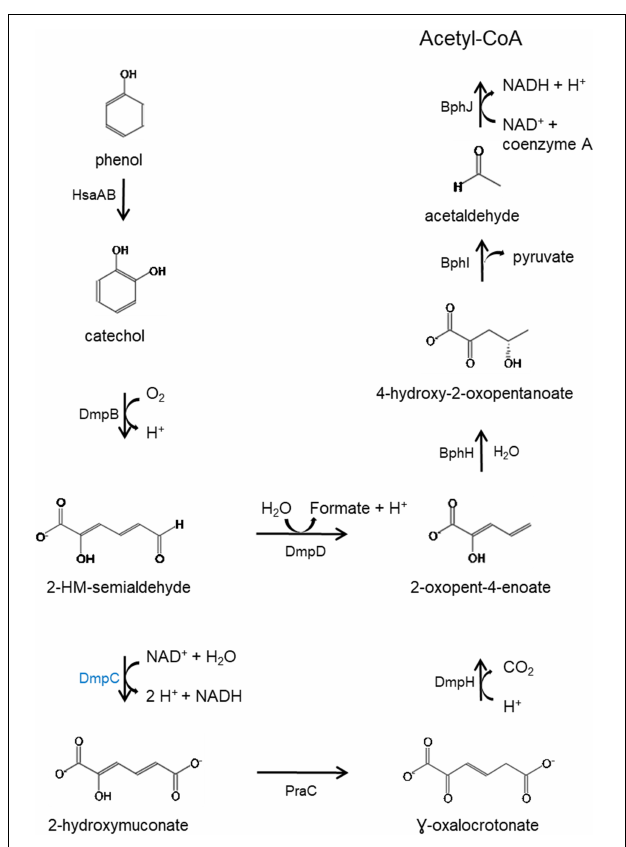
FIGURE 7 | Catabolic pathway for the degradation of phenol via meta-cleavage. HsaAB predicted as two component proteins SgcE6 (flavin reductase) and HpaB 4-hydroxyphenylacetate 3-monooxygenase and, SgcE6 (flavin reductase) and HsaA (3-hydroxy-9,10-secoandrosta-1,3,5(10)- triene-9,17-dione monooxygenase) coded by genes in the chromosomal and plasmid phenol degradation loci, respectively. Catechol is catabolized by catechol 2,3-dioxygenase (DmpB), aminomuconate-semialdehyde dehydrogenase (DmpC), 2-hydroxymuconate-semialdehyde hydrolase (DmpD), 4-oxalocrotonate tautomerase (PraC), 2-oxo-3-hexenedioate decarboxylase (DmpH), 2-oxopent-4-enoate/ cis- 2-oxohex-4-enoate hydratase (BphH), 4-hydroxy-2-oxovalerate/4-hydroxy-2-oxohexanoate aldolase (BphI) and acetaldehyde/propanal dehydrogenase (BphJ). Except HsaAB, defined above, all enzymes in black font are coded by gene in both chromosome and plasmid while DmpC, highlighted in blue is coded by the chromosomal gene ( dmpC ). 2-hydroxymuconate-semialdehyde abbreviated as 2-HM-semialdehyde. Meta-cleavage pathway adapted from Pathway Tools v22.0/MetaCyc database (Caspi et al.,